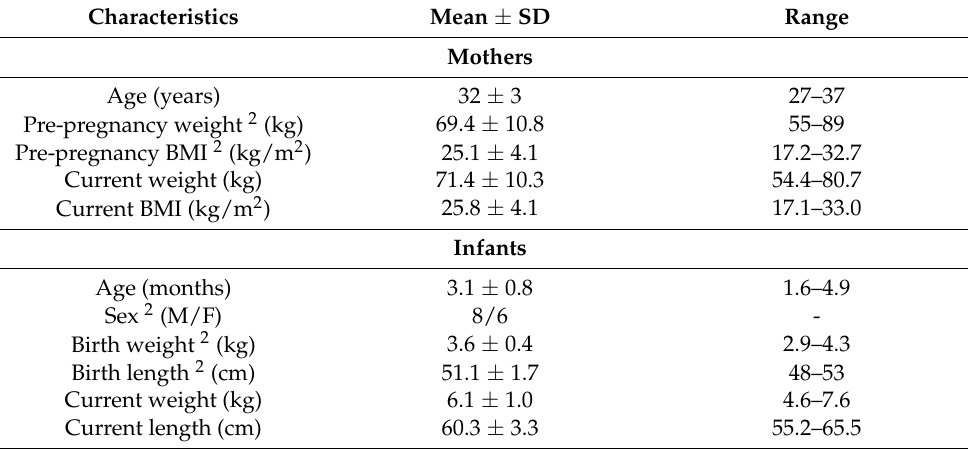
Table 2. Baseline clinical characteristics of participating mothers and infants at start of dietary intervention study 1 .